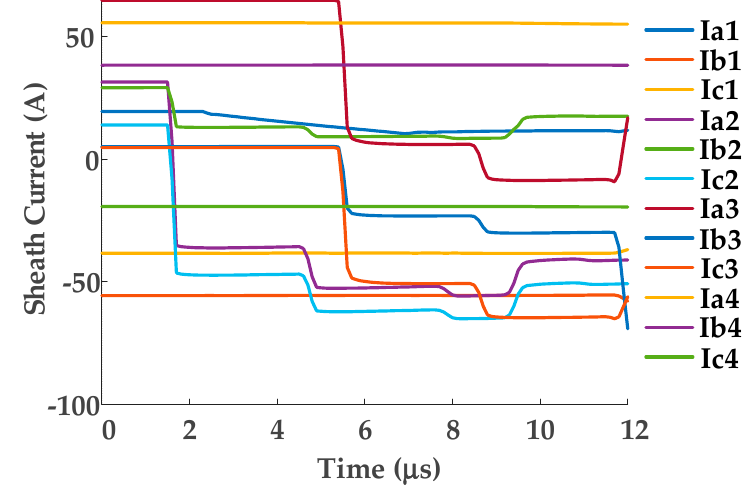
Figure 14. The 12 sheath currents for the cross-bonded HV cable.